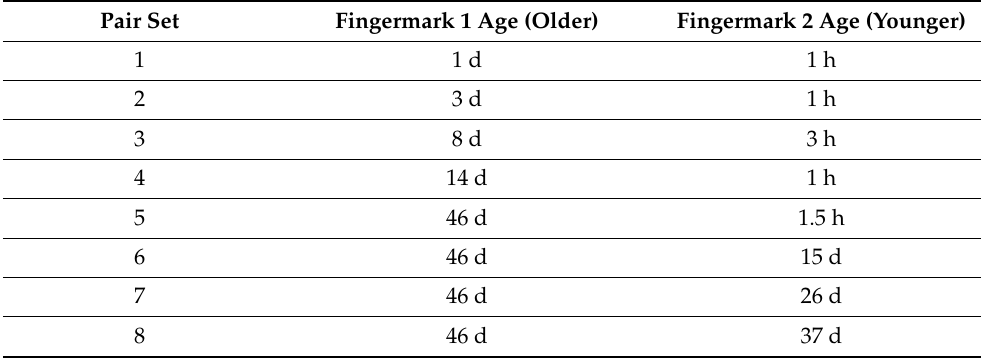
Table 1. Partially overlapping groomed fingermark pair sets prepared, aged at room temperature, and analysed by MALDI MSI. (Note “d” stands for